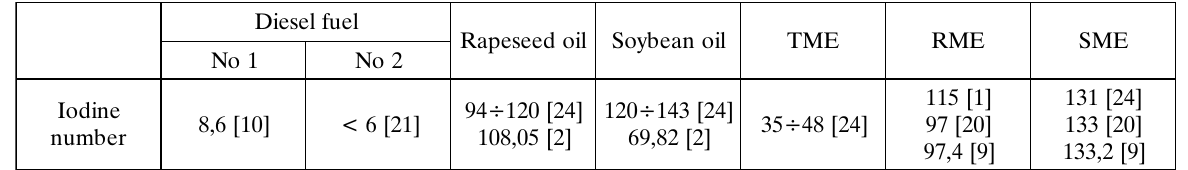
Table 9. Iodine number of fuel